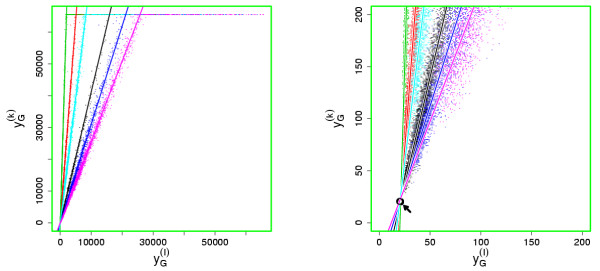
Affine relationship between quantified fluorescent intensities and concentration of fluorophores. Scanning the arrays at different PMT gains indicates that there is an affine relationship between quantified fluorescent intensities and concentration of fluorophores. Left: Observed signals in the green channel for PMT pairs (800, 500), (700, 500), (800, 600), (600, 500), (700, 600), and (800, 700) are shown in green, red, cyan, black, blue and magenta, respectively. An affine model is estimated for each pair and displayed as a line. Data points at the very top are saturated and ignored. Right: A zoom-in of the same data. For each pair the estimated , which corresponds to the true origin, has been highlighted with a circle. All lines seem to intersect at the same point on the  line. Shown are signals from the green channel on Array A quantified by GenePix from Axon scanner images.